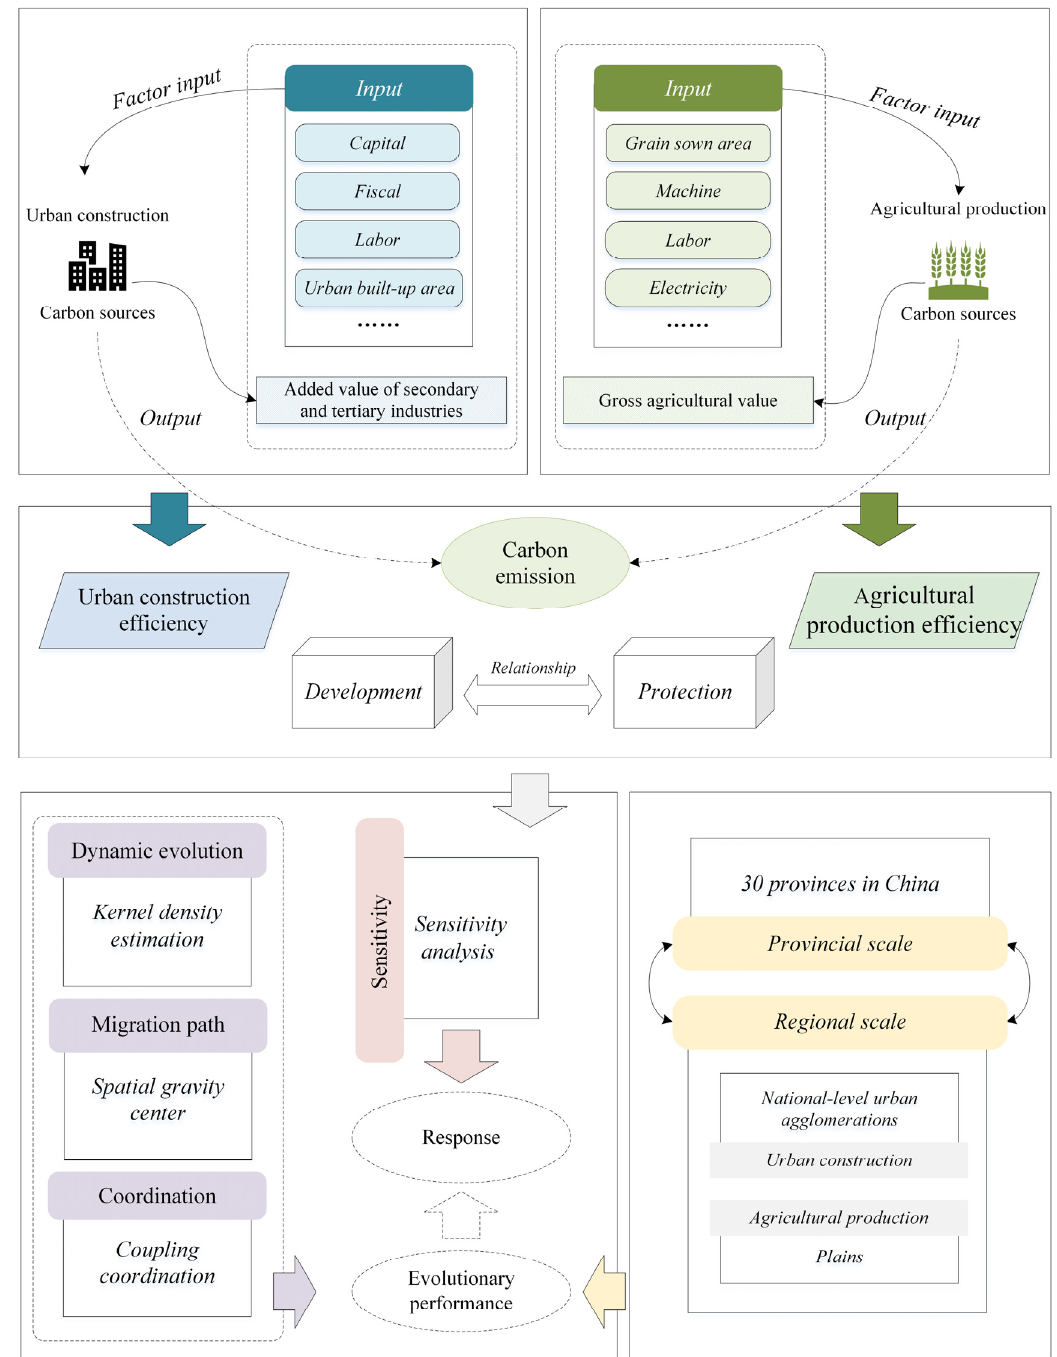
Figure 2. Conceptual framework.